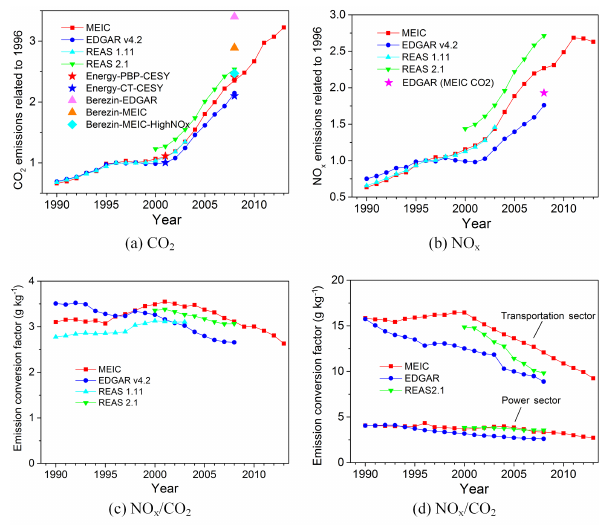
Figure 6. (a) CO 2 and (b) NO x emission trends in China, and the temporal evolution of the overall NO x -to-CO 2 ratio (c) from different inventories and (d) in different major sectors according to the MEIC, EDGAR v4.2 and REAS (v1.11 and v2.1) emis- sion inventories. The following trends (2008 values relative to 1996 values) are also shown: trends in total energy consumption from PBP-CESY (Energy-PBP-CESY) and CT-CESY-Ori (Energy-CT- CESY); NO x emission trends calculated using the CO 2 trend from MEIC and the NO x -to-CO 2 ratios from EDGAR (EDGAR − MEIC CO 2 ) ; and satellite-derived CO 2 emission trends from Berezin et al. (2013) derived using the CO 2 -to-NO x ratios from EDGAR (Berezin-EDGAR), MEIC (Berezin-MEIC) and the lower bound- ary of MEIC (Berezin-MEIC-HighNO x )